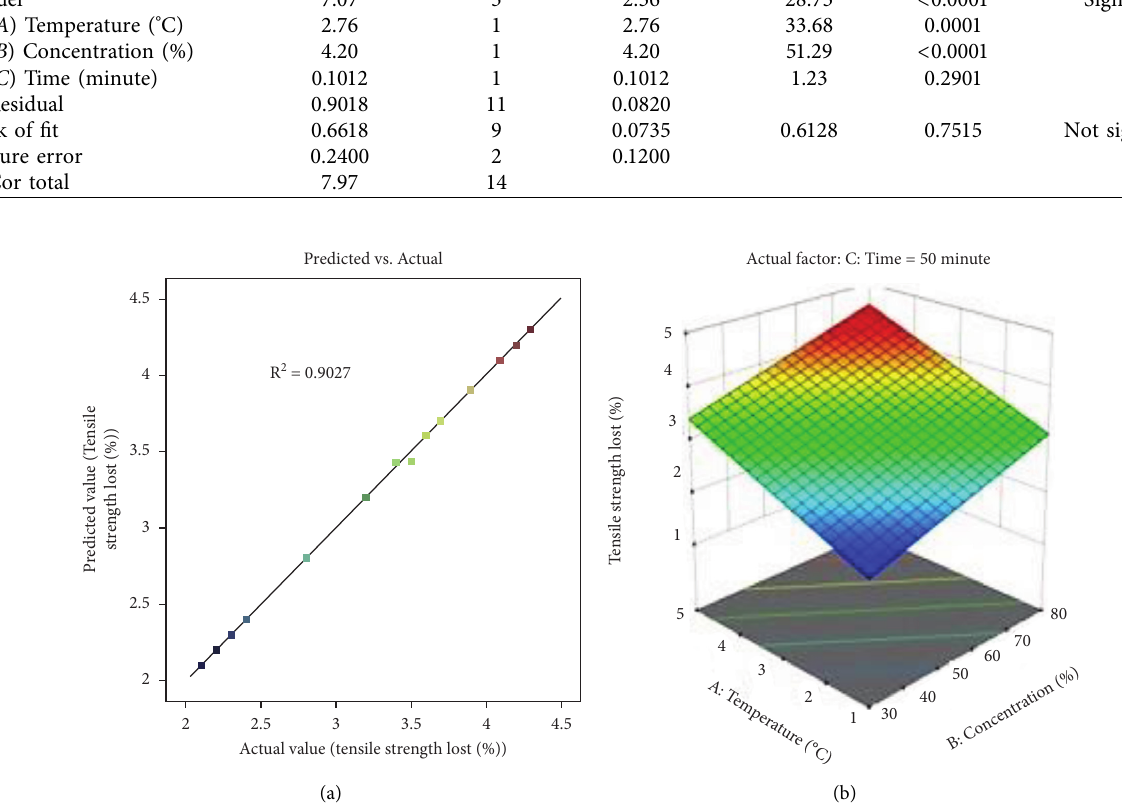
Figure 5: (a) Predicted probability plot of actual for tensile strength and (b) factor interaction effect with on 3D surface graph effect on tensile